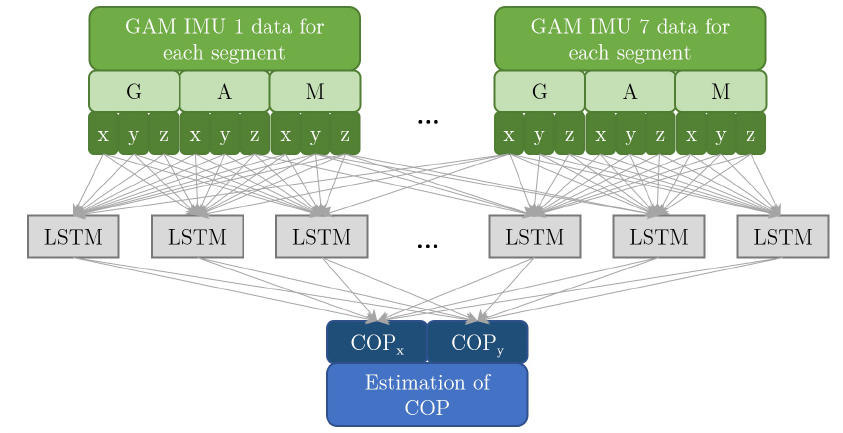
Figure 5. Architecture of the IMU-COP map using long short term memory (LSTM) artificial neural